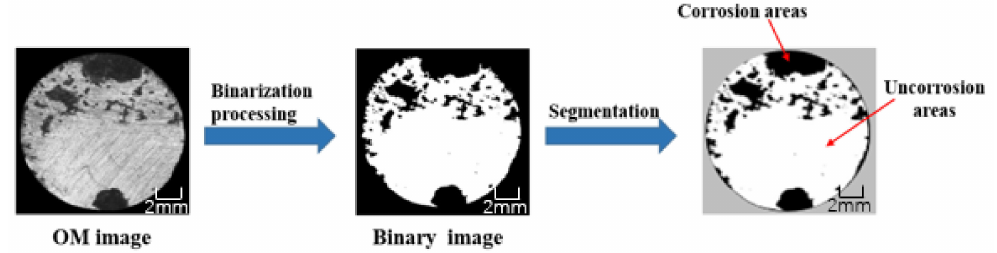
Figure 2. The main process of analyzing the OP